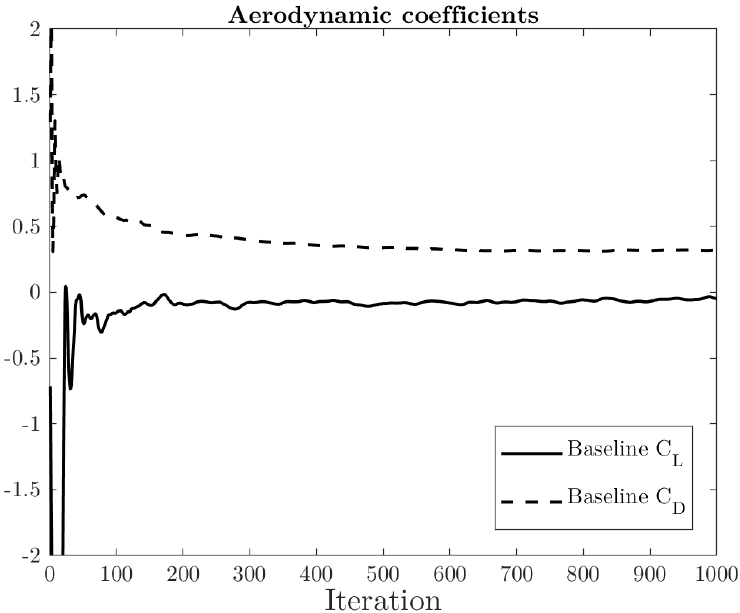
Figure 15. Stability and convergence of the aerodynamic coefficients, baseline model. The numerical results evaluated deal with both downforce ( C L ) and drag ( C D ) coeffi- cients and the aerodynamic efficiency ( E ), defined as the ratio of C L / C D